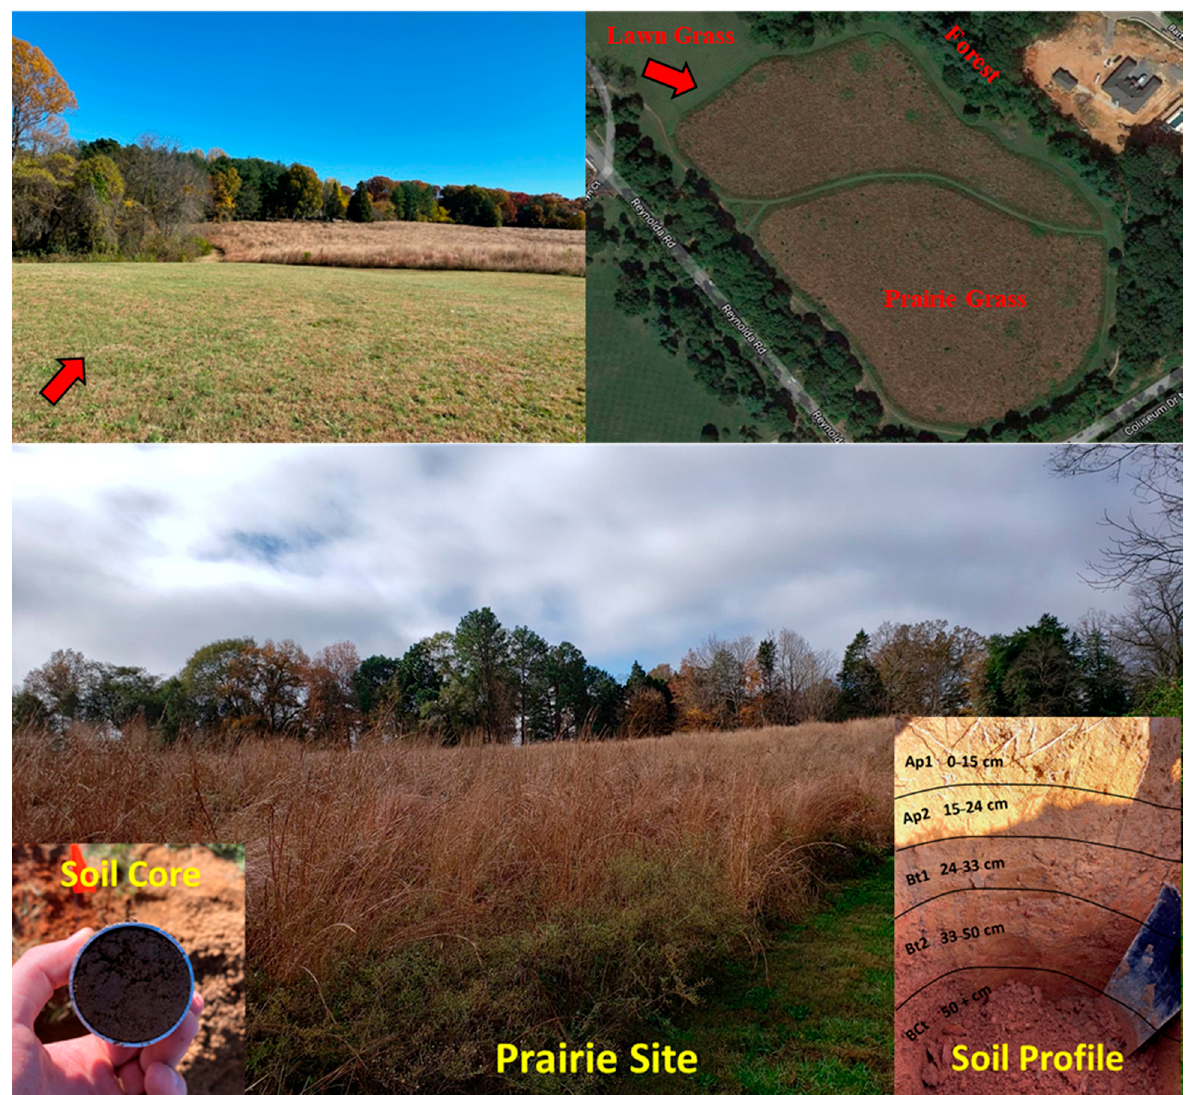
Figure 3. Soil landscape showing three different vegetation forms (prairie grass, lawn grass, and forest) with the lower left inset showing a soil core collected for determining the soil bulk density and a soil profile described and sampled.